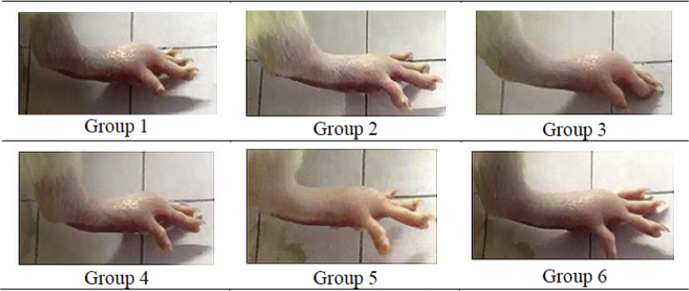
Gross photograph of paw edema of various groups of rats snapped at the 5th hour after the induction of edema. The photograph of each group was the representative of seven rats per group. Group 1 pretreated with 2% Tween 20, Group 2 was pretreated with 300 mg/kg Aspirin, Group 3, 4, 5, and 6 were pretreated with 5 mg/kg, 10 mg/kg, 25 mg/kg, and 50 mg/kg of E. cuneatum alkaloid leaf extract respectively.